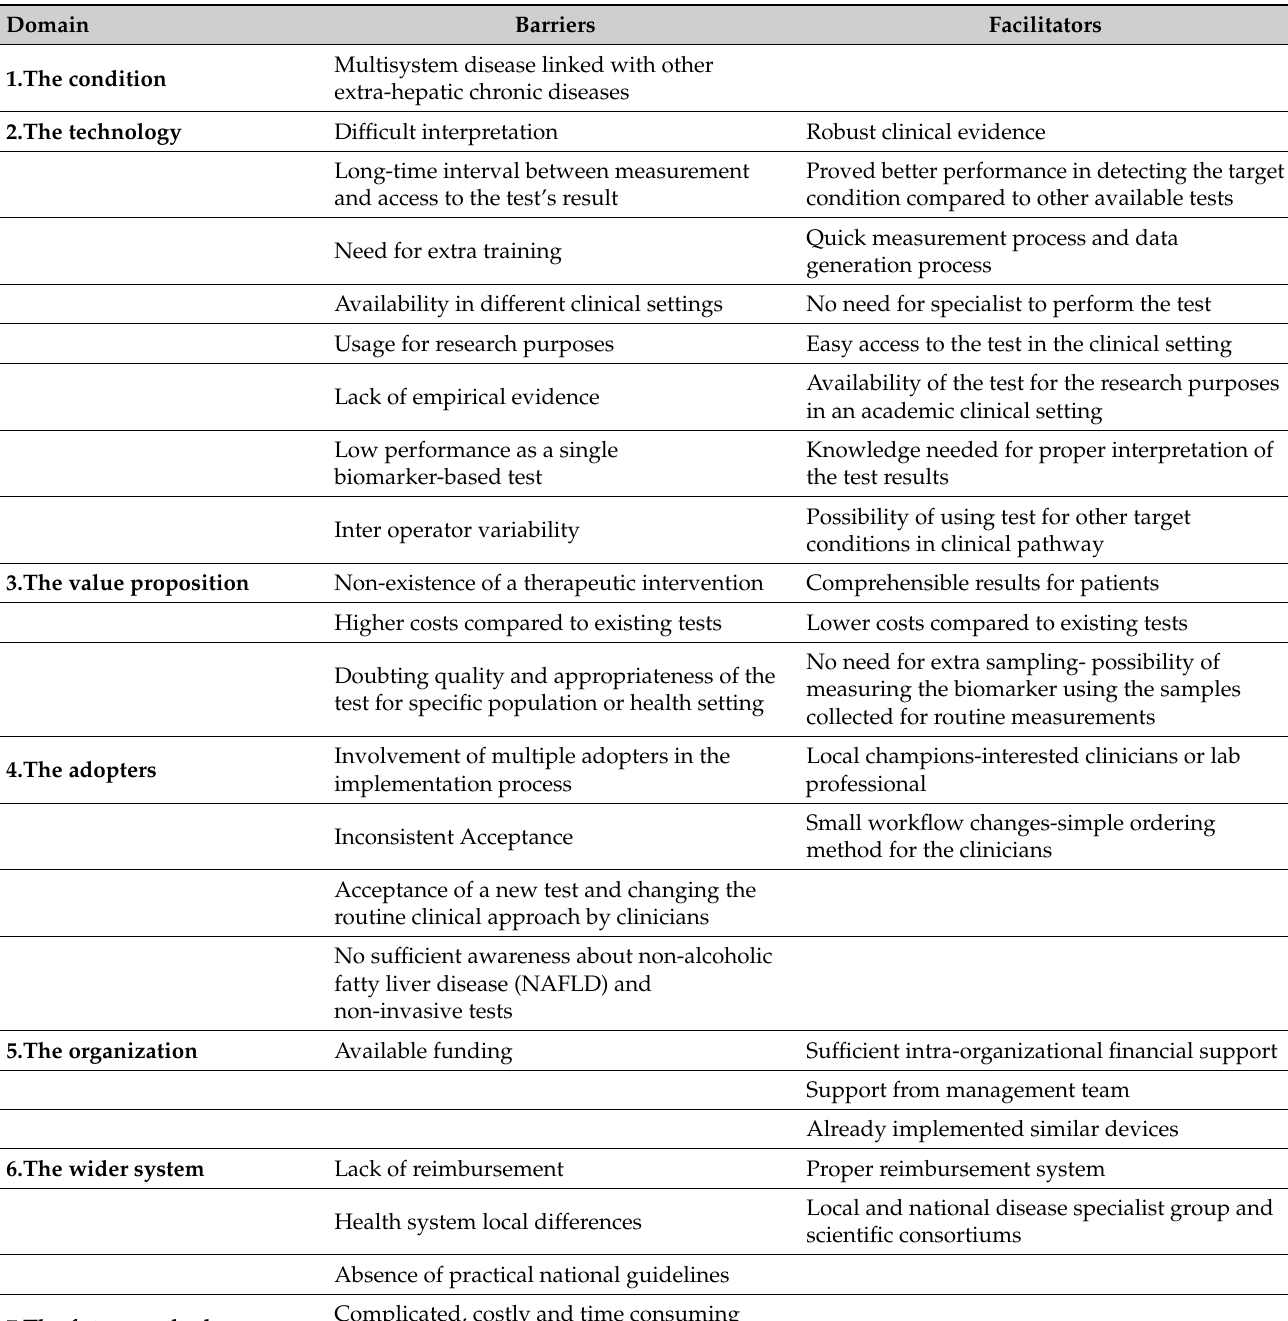
Table 2. Summary of the main facilitators and barriers sorted under the Non-adoption, Abandonment, Scale-up, Spread, and Sustainability (NASSS) framework’s